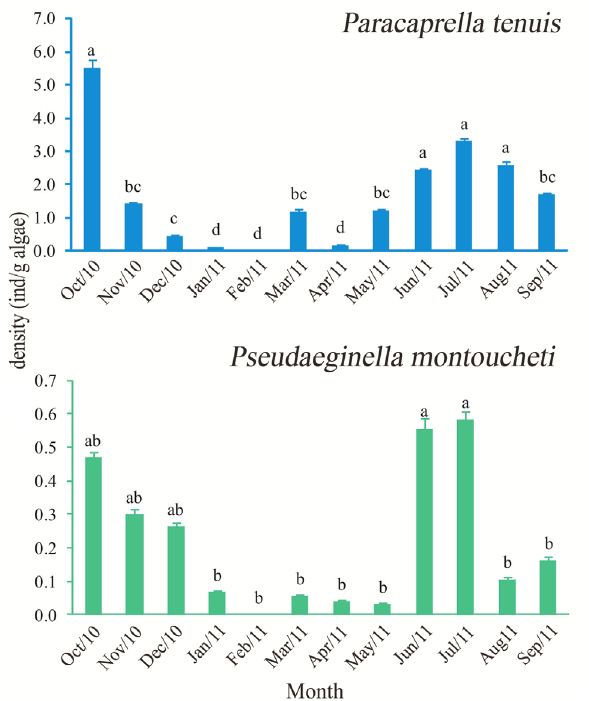
Figure 4. Monthly values of density (ind./g of algae) (mean ± standard error) of Paracaprella tenuis and Pseudaeginella montoucheti from October 2010 to September 2011.